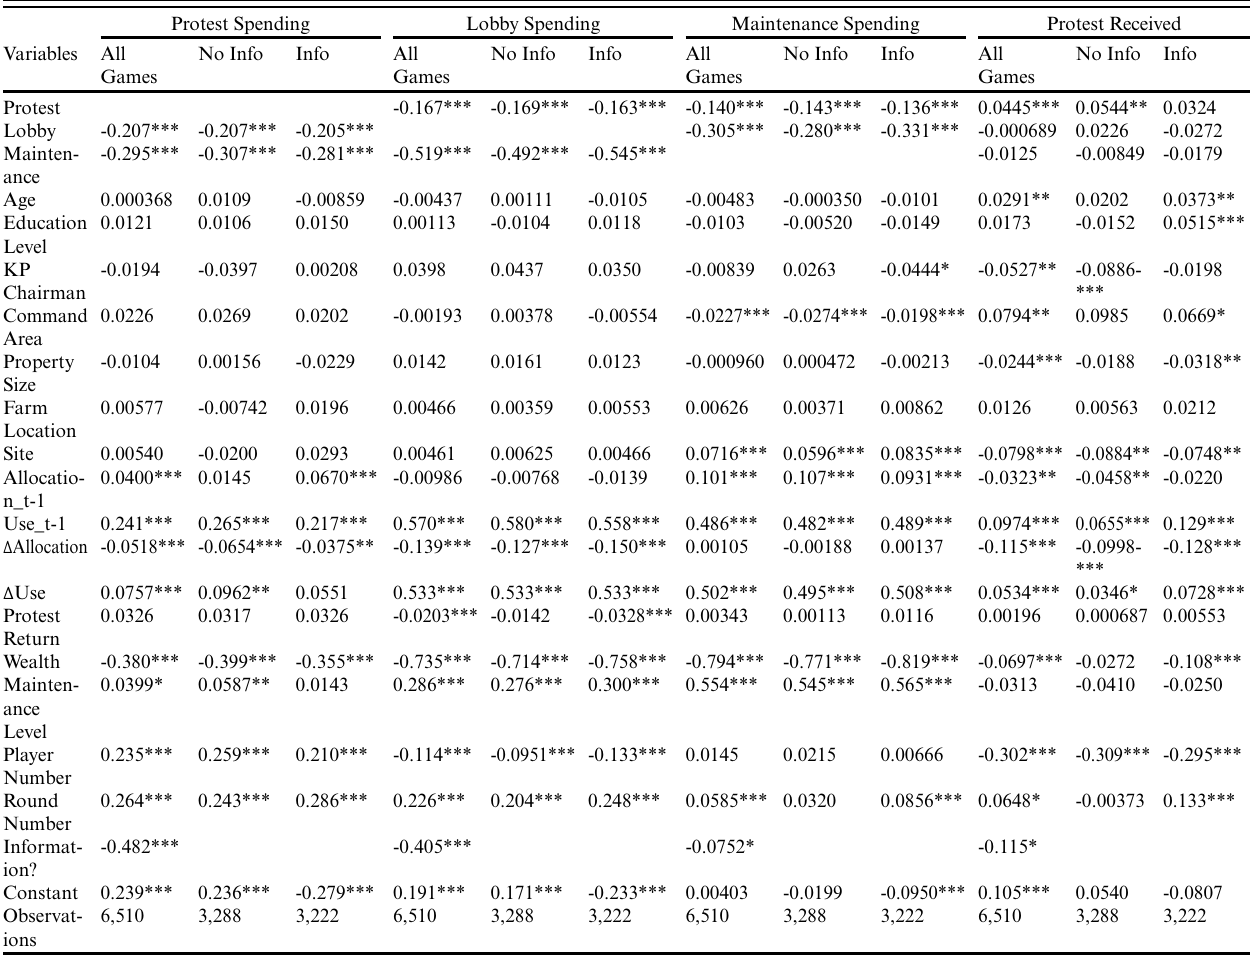
Table 2 . Overall game regressions. Protest